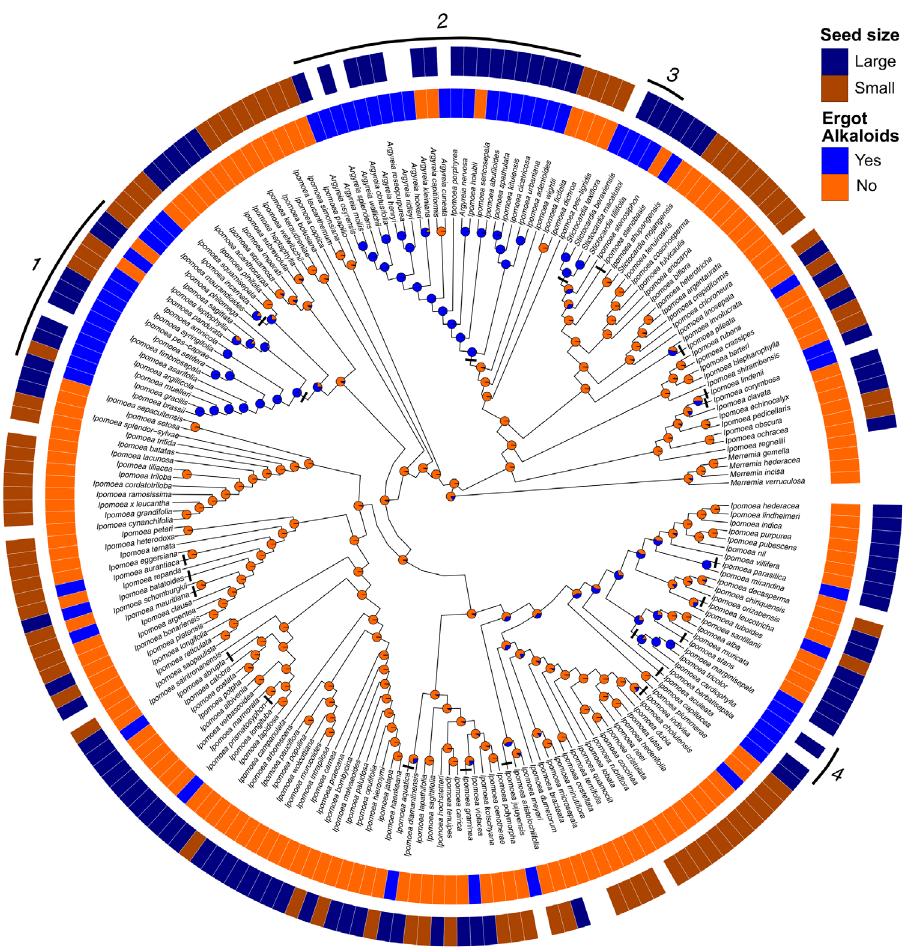
Fig. 3 Ancestral state reconstruction of EA presence. Phylogenetic distribution of EA presence and seed mass. Species lacking seed mass data are represented by blank spaces. Pie charts at nodes indicate the relative likelihoods of the alkaloid ancestral character state. Black bars represent the origins of symbiosis. Lines and numbers indicate major clades of EA + species: (1) Pes-caprae, (2) ATP, (3) Stictocardia, (4) Tricolores.